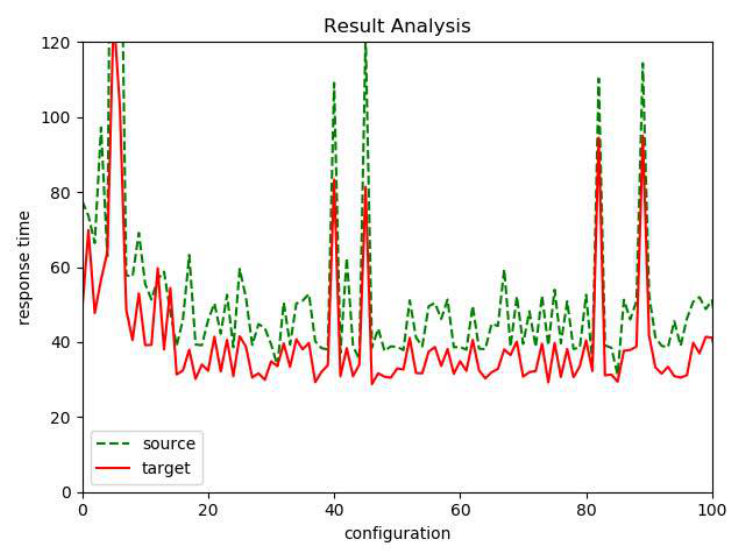
Figure 2. Performance models exhibit similarities across different database